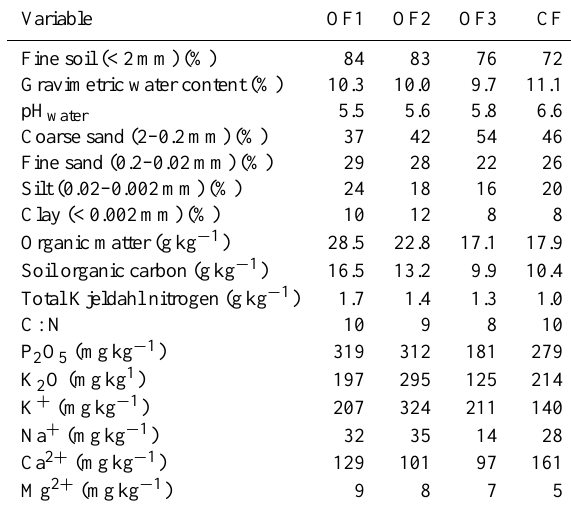
Soil carbon was similar in all plots, soil nitrogen was high- est in OF1 and lowest in OF3 ( P = 0.008; Fig. 1), and soil phosphorus was highest in OF1 and lowest in CF ( P = 0.001; Fig. 1). Soil C : N attained highest values at OF2 with no sig- nificant differences among plots, and C : P ratios and N : P ratios were highest in CF and lowest in OF3 ( P = 0.013 and P = 0.009, respectively; Fig. 1). Microbial carbon and nitro- gen were similar in all plots, microbial phosphorus attained highest values in OF2 and lowest in CF and was signifi- cantly different between CF and OF2 or OF3 ( P = 0.002; Fig. 1). C : N and C : P ratios attained highest values in CF while N : P ratios attained highest values in OF1 with no significant differences among plots. C microbial quotient (C micro : C soil ) attained highest values in OF1, but there were no significant differences among plots. N microbial quo- tient (N micro : N soil ) was significantly different between OF2 and OF3 ( P = 0.014; Fig. 1) while P microbial quotient (P micro : P soil ) was highest in OF2 and significantly different between OF1 and OF2 ( P = 0.015; Fig.